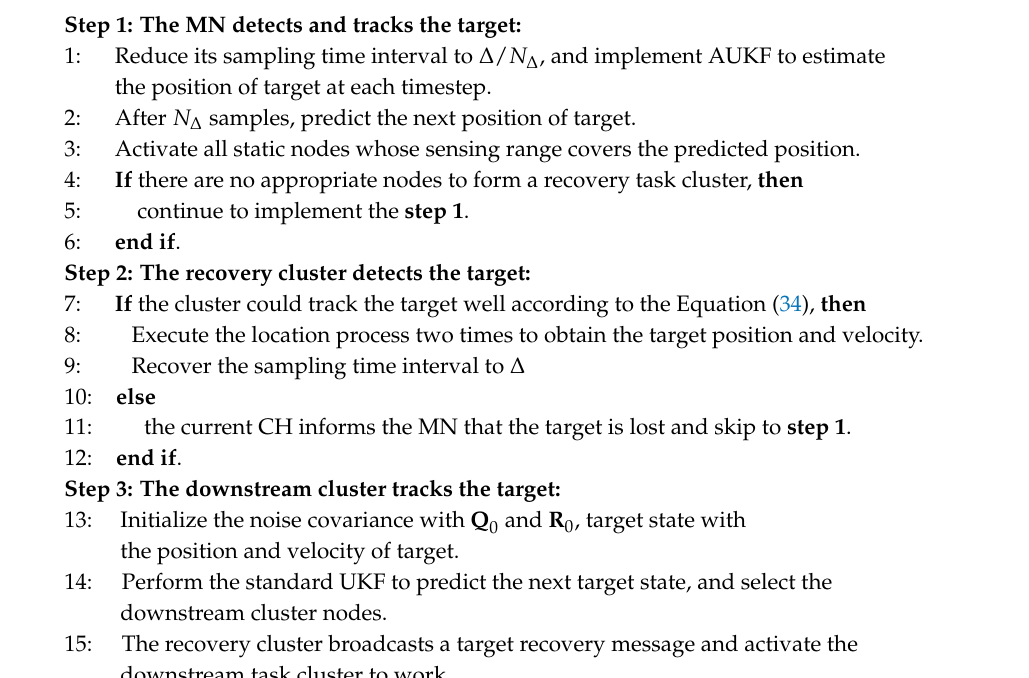
Algorithm 2: The target recovery